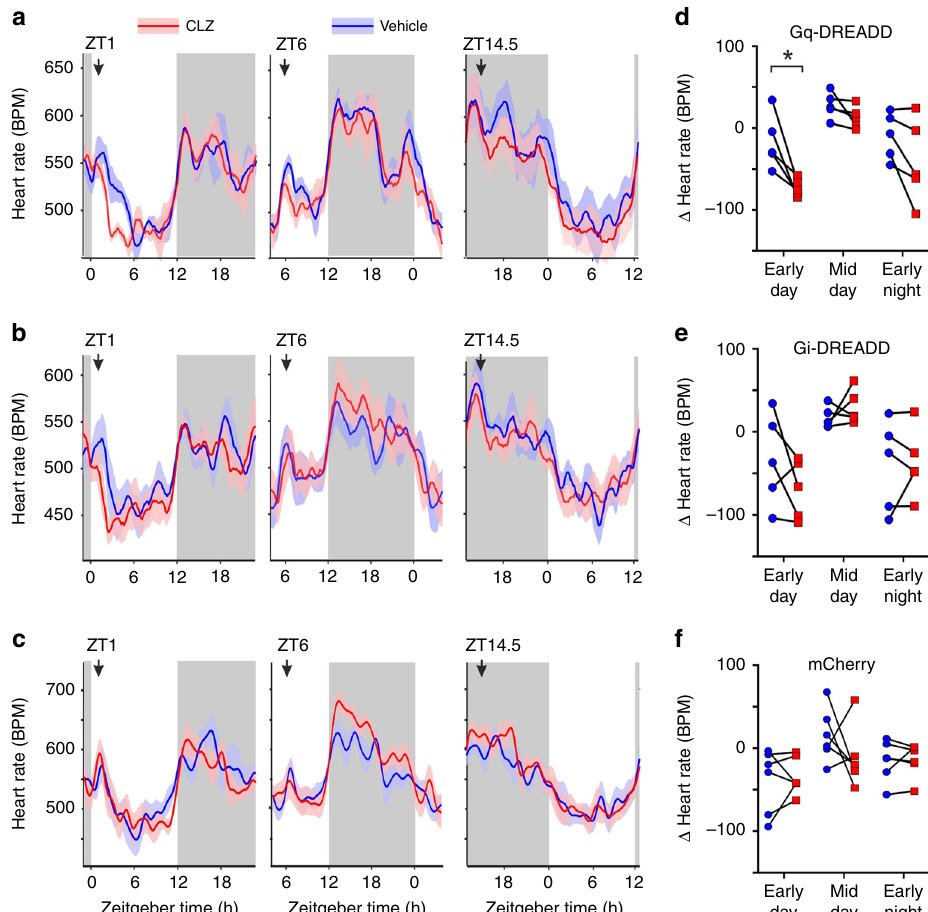
Fig. 7 Chemogenetic excitation of SCN VIP cells modulates heart rate during the early day. a – c Heart rate following vehicle or clozapine (CLZ; 0.1 mg/kg i.p.) injections at varying portions of the daily cycle in animals expressing Gq- ( a ), Gi-DREADD ( b ) or mCherry ( c ) in SCN VIP cells. Arrows above traces indicate timing of injections; grey shaded areas represent time of lights off. d – f Change in heart rate 1 – 5 h post vehicle or clozapine injection (relative to mean values in the 2 h epoch preceding injection) for Gq- ( d ), Gi-DREADD ( e ) and mCherry ( f ) expressing mice. Data were analysed by two-way RM- ANOVA ( d : CLZ: F 1, 4 = 891.3, P < 0.0001; Epoch: F 2, 8 = 16.57, P = 0.0014; Epoch X CLZ: F 2, 8 = 1.84, P = 0.22; e : CLZ- F 1, 4 = 0.52, P = 0.51; Epoch: F 2, 8 = 6.76, P = 0.02; Epoch X CLZ: F = 2.06, P = 0.19; f : CLZ: F = 0.52, P = 0.50; Epoch: F = 3.48, P = 0.07; Epoch X CLZ: F = 1.28, P = 0.32). 2, 8 1, 5 2, 10 2, 10 of CLZ). * P <